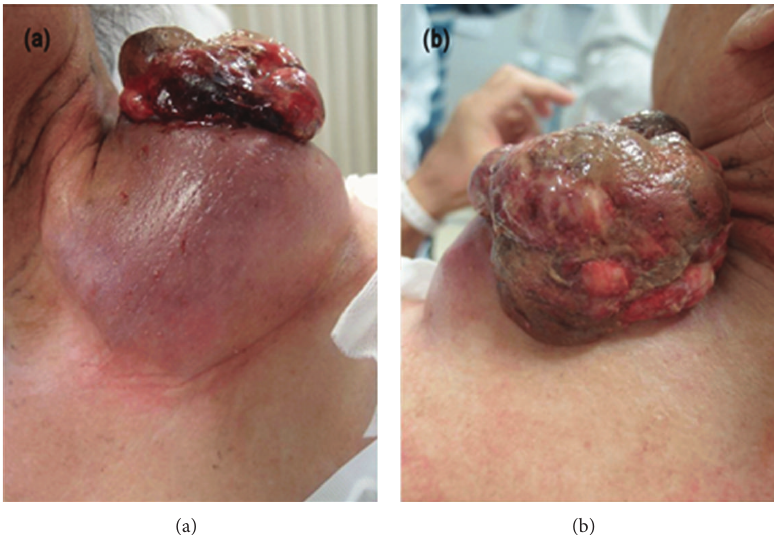
Figure 1: Most part of the tumor was confined into the epidermal cyst although cauliflower-like excrescence was observed from the fissure. (a) Anterior side. (b) Posterior side.